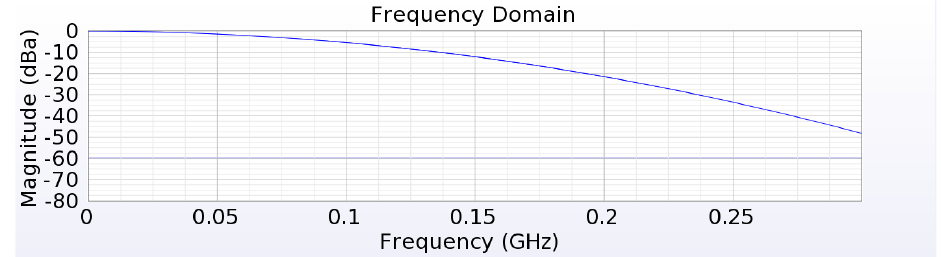
Figure 3. Frequency - domain waveform of Gaussian pulse current source .